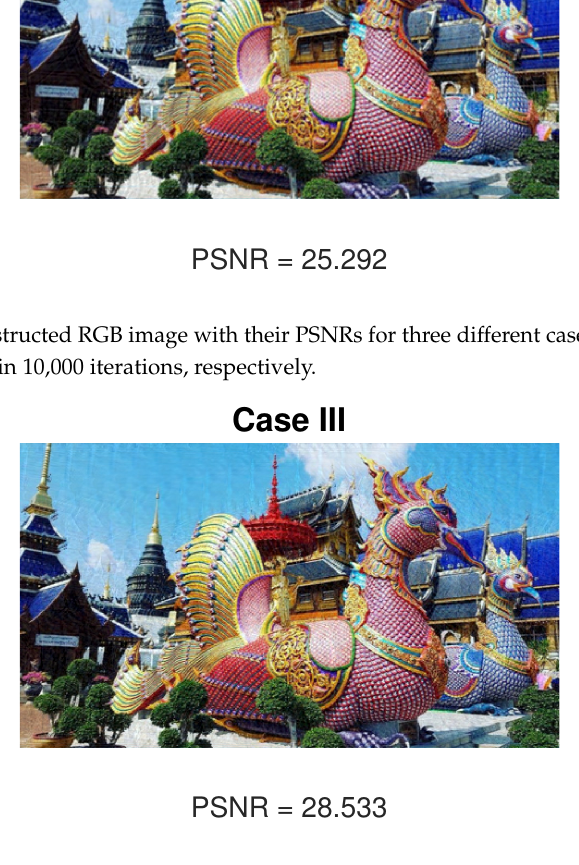
Figure 21. The reconstructed RGB image with their PSNRs for three different cases using the proposed algorithm presented in 10,000 iterations,